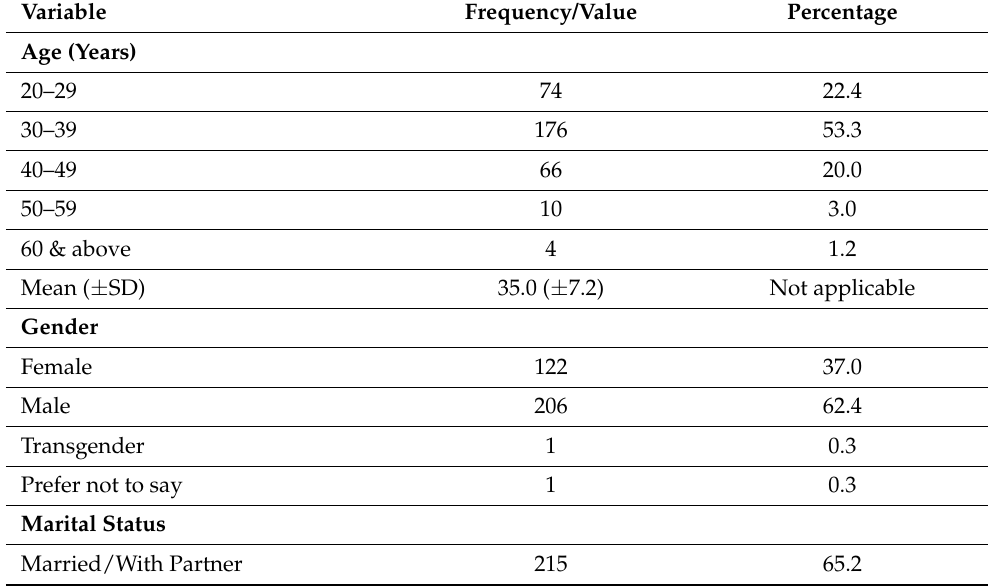
Table 1. Background characteristics of the